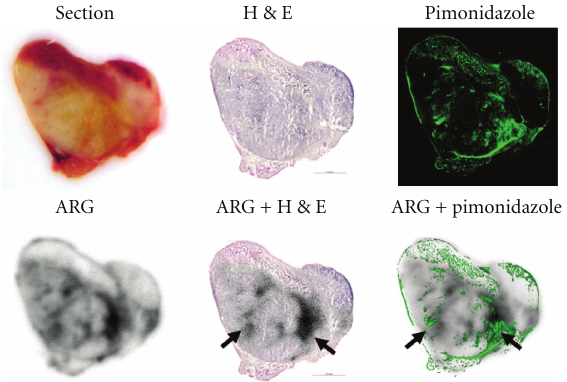
Figure 2: Intratumoral distribution of 125 I-POS, pimonidazole. Administration dose of 125 I-POS 2.0 MBq, POS: 30 μ g, tumor weight: 0.3g, tumor uptake 5.2%, slice thickness for ARG 20 μ m, slice thickness for staining 6 μ m.